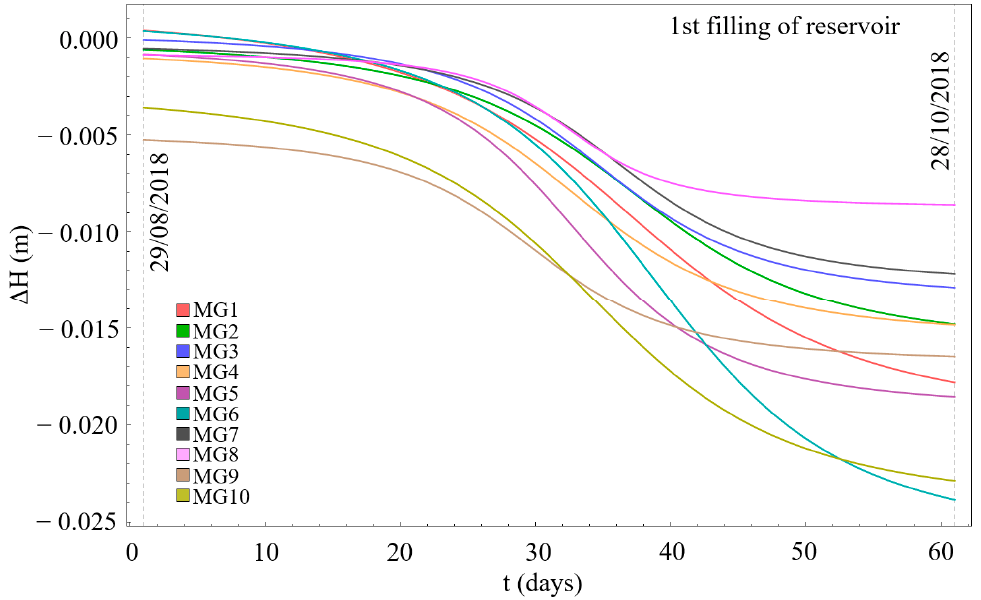
Figure 13. Fitted Faculty of Natural Sciences and Engineering (FNSE) models for points MG1 to M10, from 29/08/2018 to 28/10/2018.